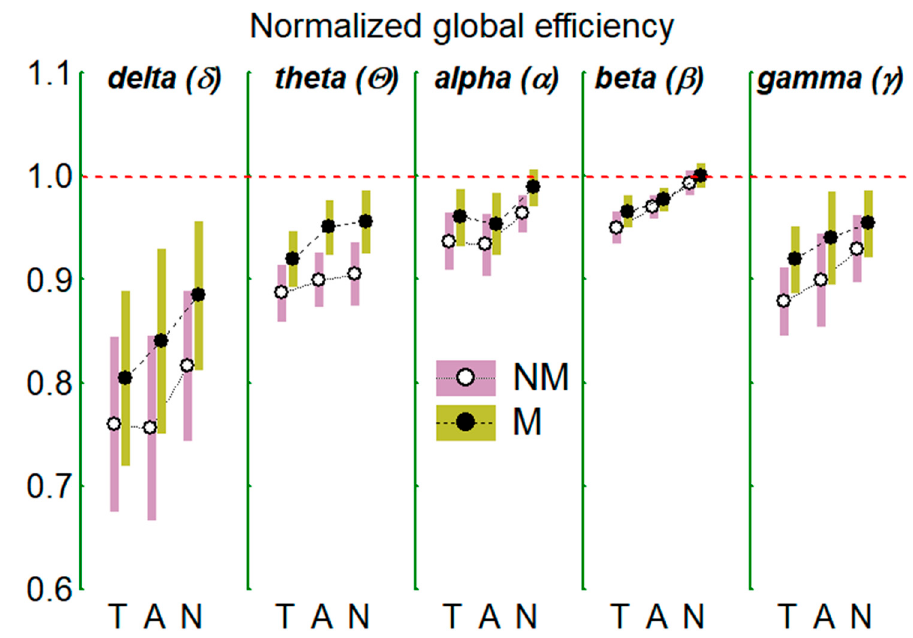
Figure 8. As in Figure 7 but for the normalized local efficiency of the EEG graph/network.